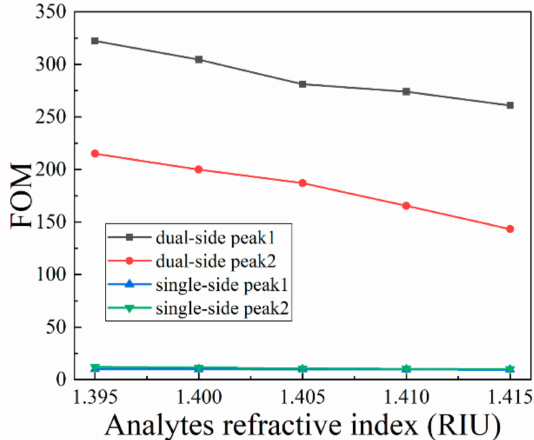
Figure 7. Dependence of figure of merit (FOM) of the two sensors on the analyte RI when d 1 = 0.70 µ m,